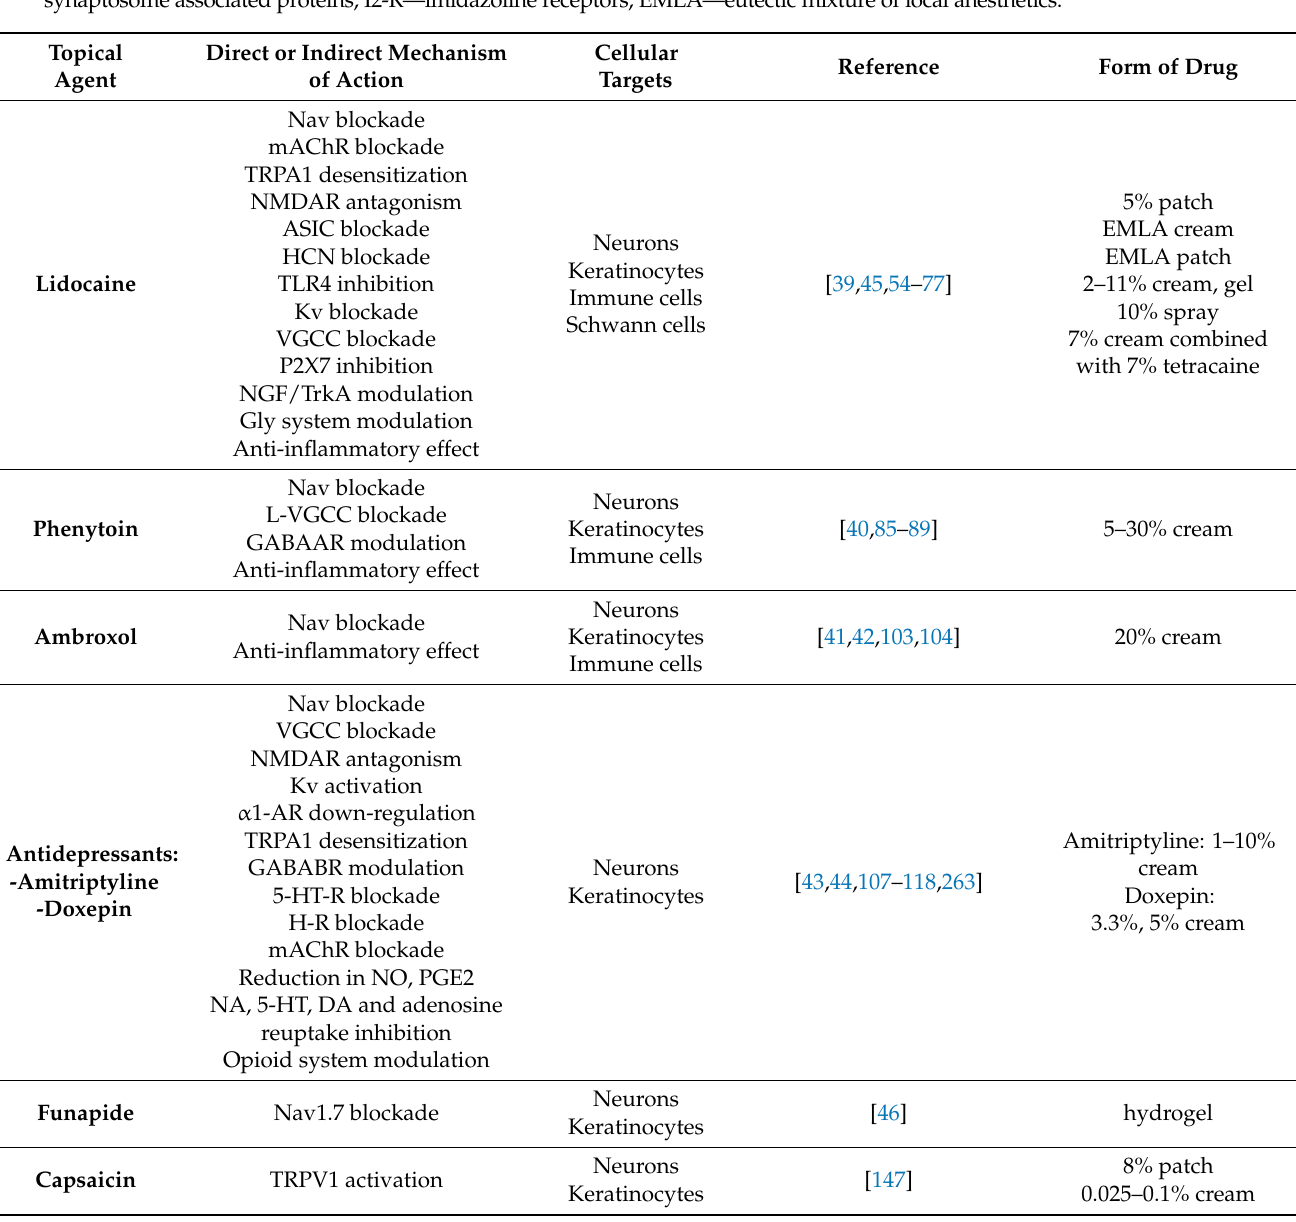
Table 1. Possible direct or indirect mechanisms of antinociceptive action of topical agents, cells influenced by a given agent, and form of drug used in clinical trials and/or daily practice in patients with LNP. Presented references refer to possible mechanisms of action. Abbreviations: Nav—voltage-gated sodium channels, TRPV1—transient receptor potential vanilloid 1, TRPA1—transient receptor potential ankyrin 1, TRPM8—transient receptor potential melastatin 8, TRPM3—transient receptor potential melastatin 3, mAChR—muscarinic acetylcholine receptors, nAChR—nicotinic acetylcholine receptors, VGCCs—voltage-gated calcium channels, L-VGCCs—L-type voltage-gated calcium channels, NMDAR—N-methyl- D -aspartate receptors, ASIC—acid-sensing ion channels, P2X7—P2X purinoceptor 7, PGE2—prostaglandin E2, GABAAR —gamma-aminobutyric acid receptors A, GABABR—gamma- aminobutyric acid receptors B, Kv—voltage-gated potassium channels, K+—potassium, OR—opioid receptors, CB1—cannabinoid receptor type 1, 5-HT—serotonin, 5-HT-R—serotonin receptors, GPCR—G protein-coupled receptors, TLR4—Toll-like receptor 4, HCN—hyperpolarization-activated cyclic nucleotide-gated channels, NGF—nerve growth factor, TrkA—tropomyosin receptor kinase A, Gly—glycine, α 1-AR— α 1 adreno receptor, α 2-AR— α 2 adreno receptor, H-R—histamine receptor, DA—dopamine, NA—noradrenaline, NO—nitrous oxide, COX-2—cyclooxygenase 2, OR—opioid receptors, KOR— κ opioid receptors, SNAP— synaptosome associated proteins, I2-R—imidazoline receptors, EMLA—eutectic mixture of local